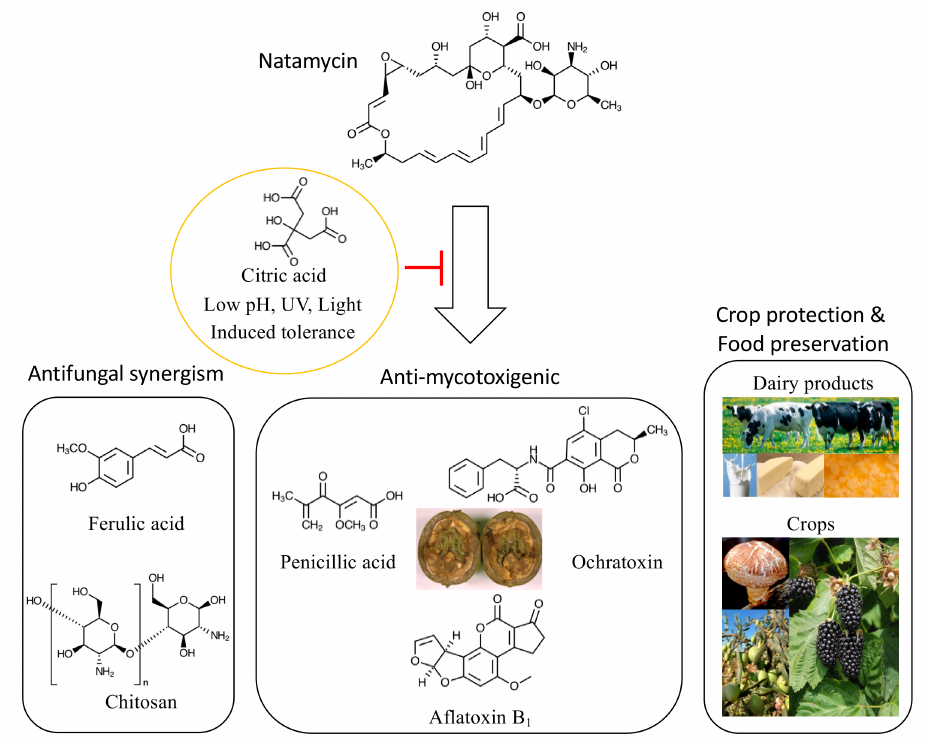
Figure 1. Natamycin usage in agricultural and food industries for crop protection, food preservation, and mycotoxin prevention (courtesy: USDA; see Table S1). Note that pH, light, UV, and food ingredients greatly affect the efficacy of